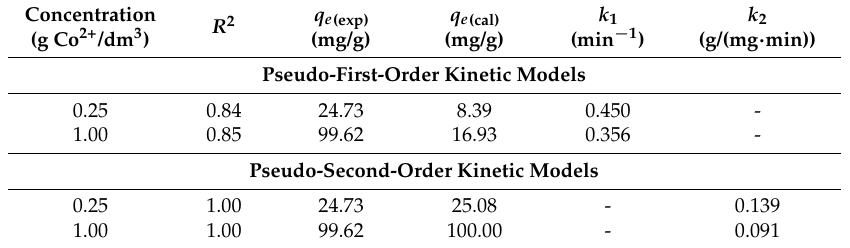
Table 1. The kinetic parameters of the pseudo-first- and pseudo-second-order kinetic